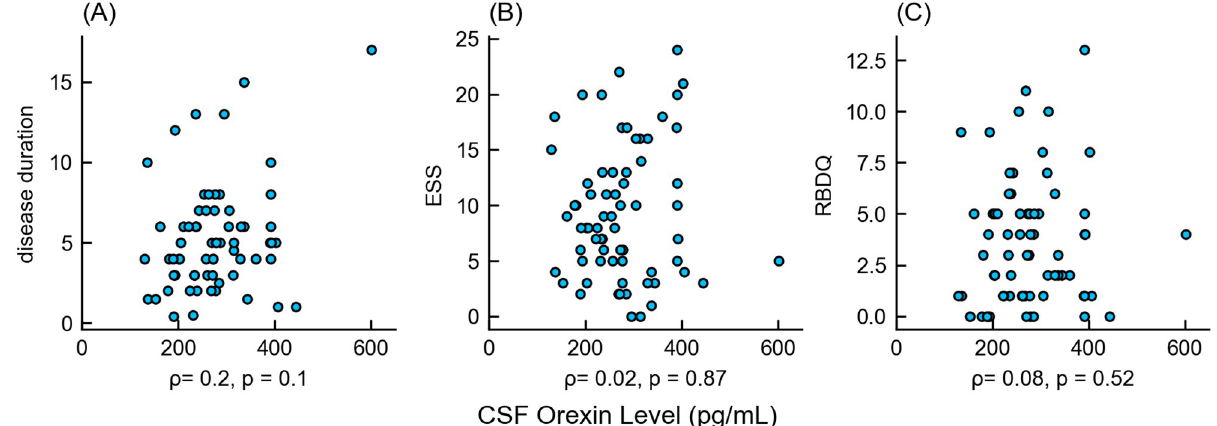
Fig 3. Correlation between orexin levels and clinical characteristics in patients with Parkinson’s disease. In each scatter plot, the x-axis shows CSF orexin levels and the y-axis shows (A) disease duration, (B) ESS, and (C) RBDQ. The disease duration was scaled by year. All these clinical characteristics showed poor correlation with CSF orexin levels, and the correlation coefficients were not statistically significant. CSF, cerebrospinal fluid; ESS, Epworth Sleepiness Scale; RBDQ, Rapid Eye Movement Sleep Behavior Disorder